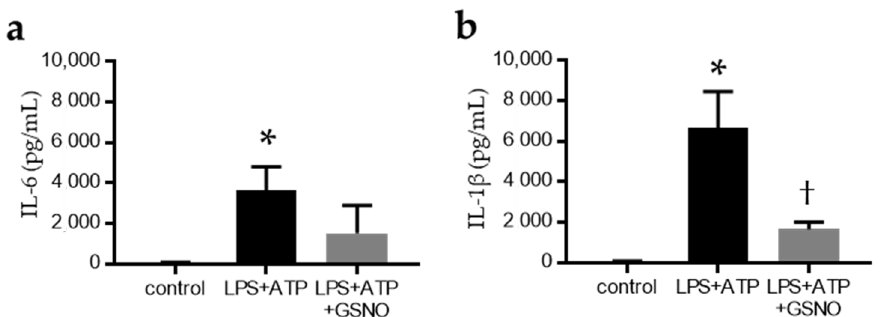
Figure 6. NO directly regulates inflammasome-related cytokines in primary cultured macrophages.